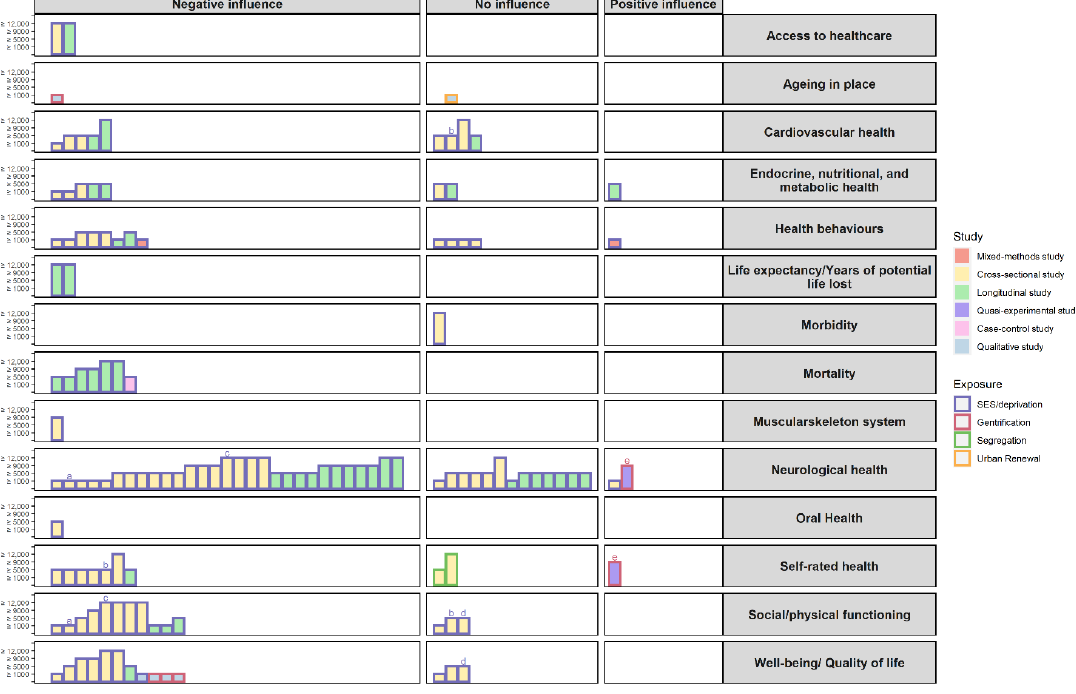
Figure 6. Harvest plot summarising the features of the studies included. Each bar represents a single study; however, each study can appear more than once if the authors analysed more than one out- come of the healthy ageing categories; in those cases, the bars are identified with the same letter above it (a = Kwag et al., 2011, b = Wight et al., 2008, c = Basta et al., 2007, d = Vogt et al., 2015, e = Smith, Lehning, and Kim 2018). The height of the bars is proportional to the number of participants in the studies. The colour fill of the bars represents the type of study used and the colour of the contour of the bar represents the neighbourhood exposure.